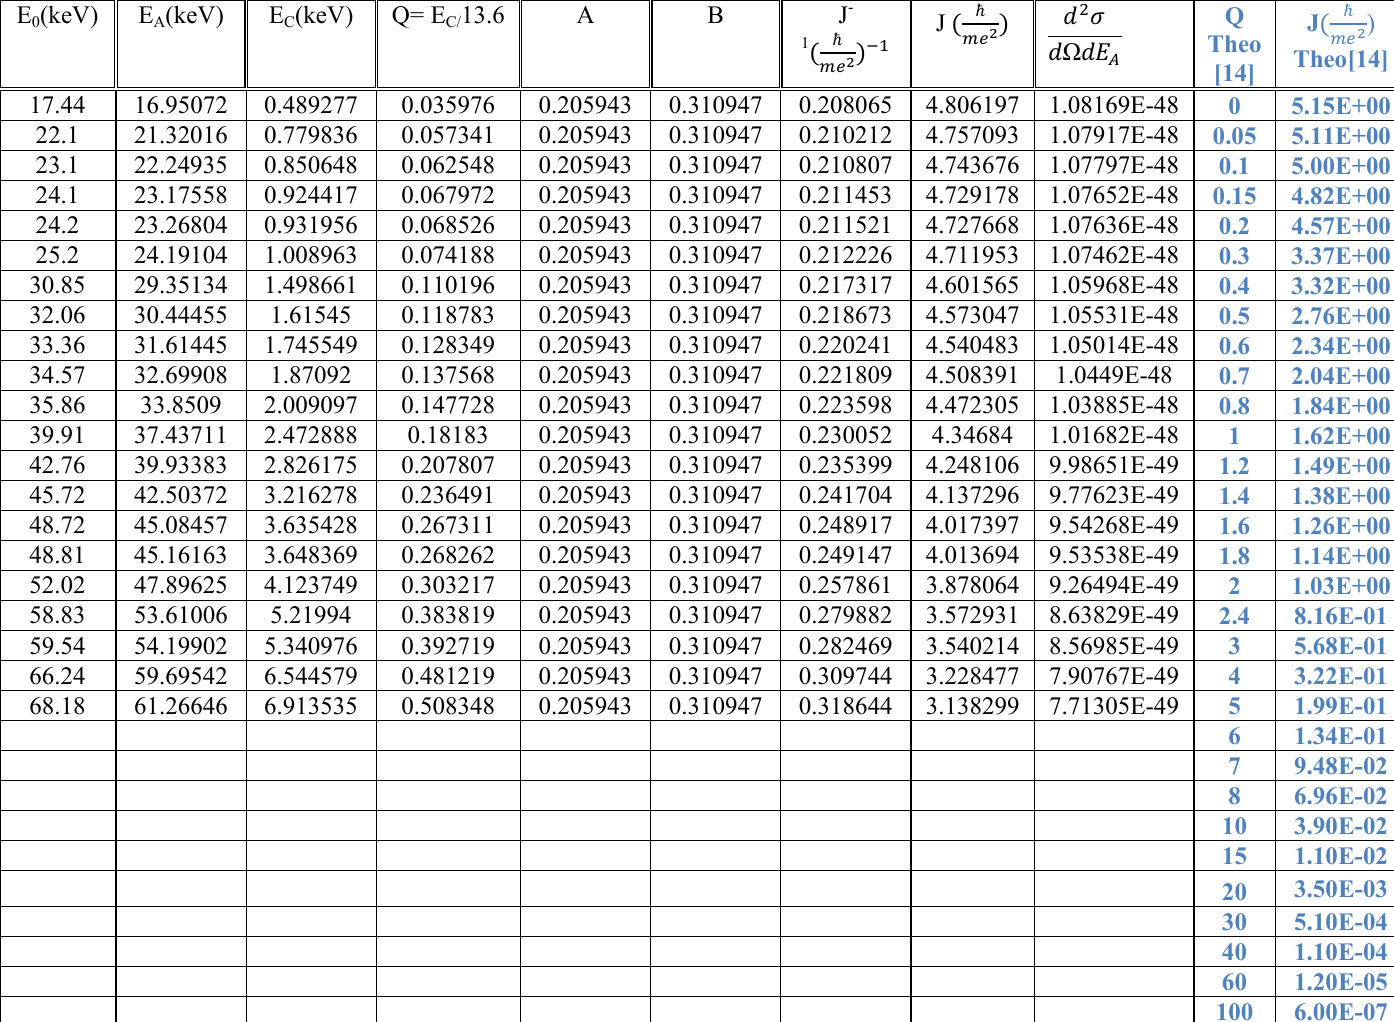
Table 1: The double-differential scattering cross section of Doppler broadening at angle (cid:2780)(cid:2777) ° for